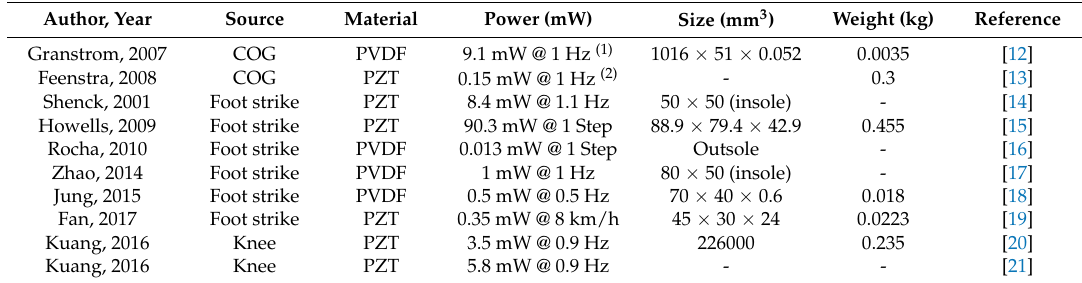
Table 2. Wearable piezoelectric energy harvesters.